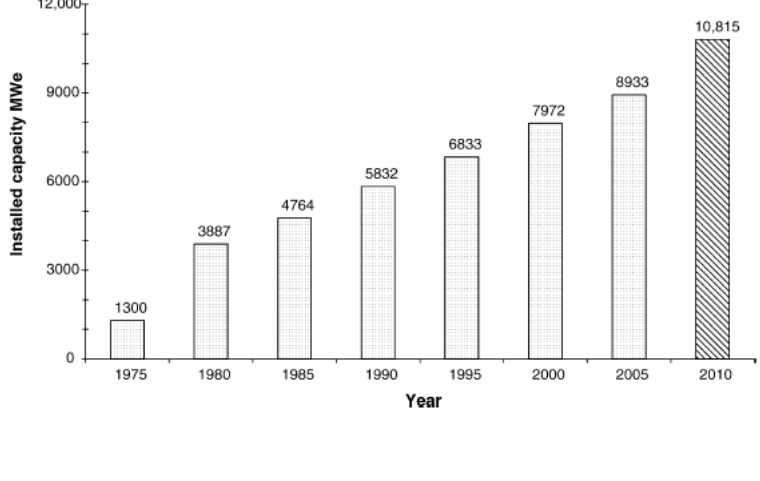
Figure 73. Increase and projected increase in geothermal power deployment since 1975. © 2005 Elsevier, reproduced with permission from